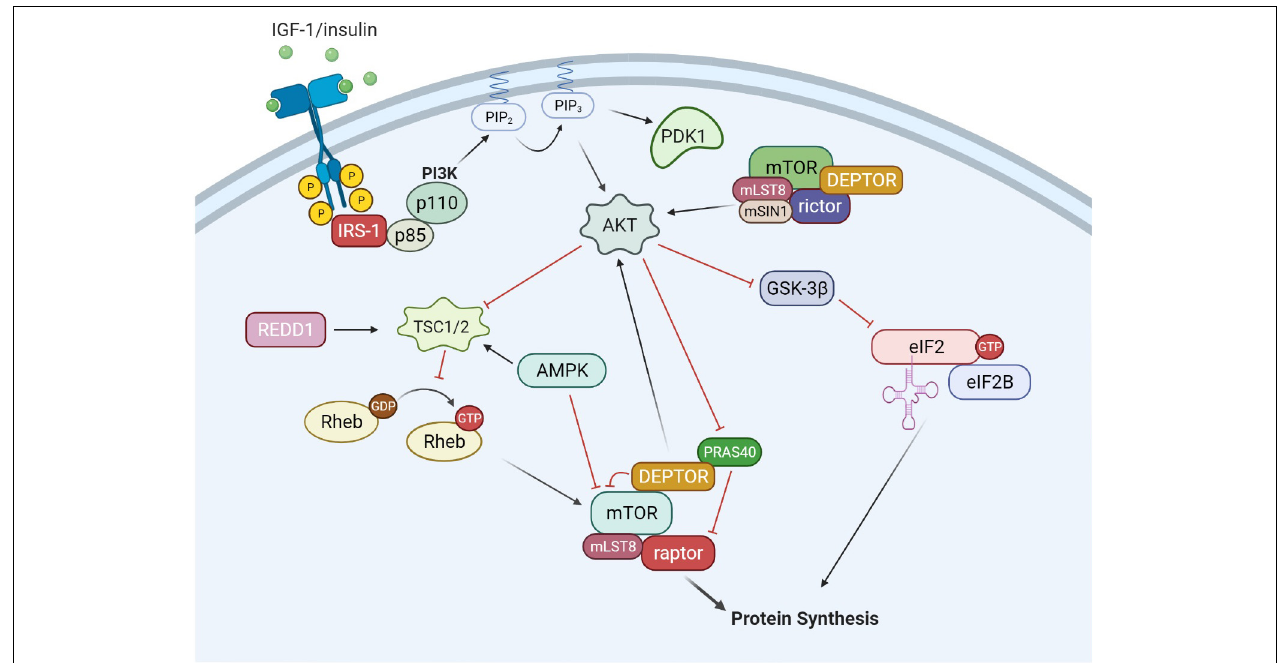
FIGURE 2 | IGF-1/Akt signaling. The binding of growth factors such as IGF-1 and insulin activates receptor tyrosine kinases (RTKs), which recruits and activates IRS-1. IRS-1 then activates phosphatidylinositol-4,5-bisphosphate 3-kinase (PI3K), which consists of a regulator subunit (p85) and a catalytic subunit (p110). PI3K generates phosphoinositide 3,4, 5-phosphate (PIP 3 ). PIP3 recruits and activates PDK1 and Akt. In addition to PIP3 signaling, mTORC2 can also phosphorylate and activate Akt. From there, Akt can signal through both mTORC1 and eIF2 pathways to increase protein synthesis. Akt can phosphorylate and inactivate GSK-3 β , which is an inhibitor of the eIF2 complex. Akt can also activate the mTORC1 complex through inactivation of TSC1/2 and PRAS40. AMPK is a negative regulator of the IGF-1/Akt pathway, inhibiting mTORC1 activity through activation of the TSC1/2 complex and direct inhibition of